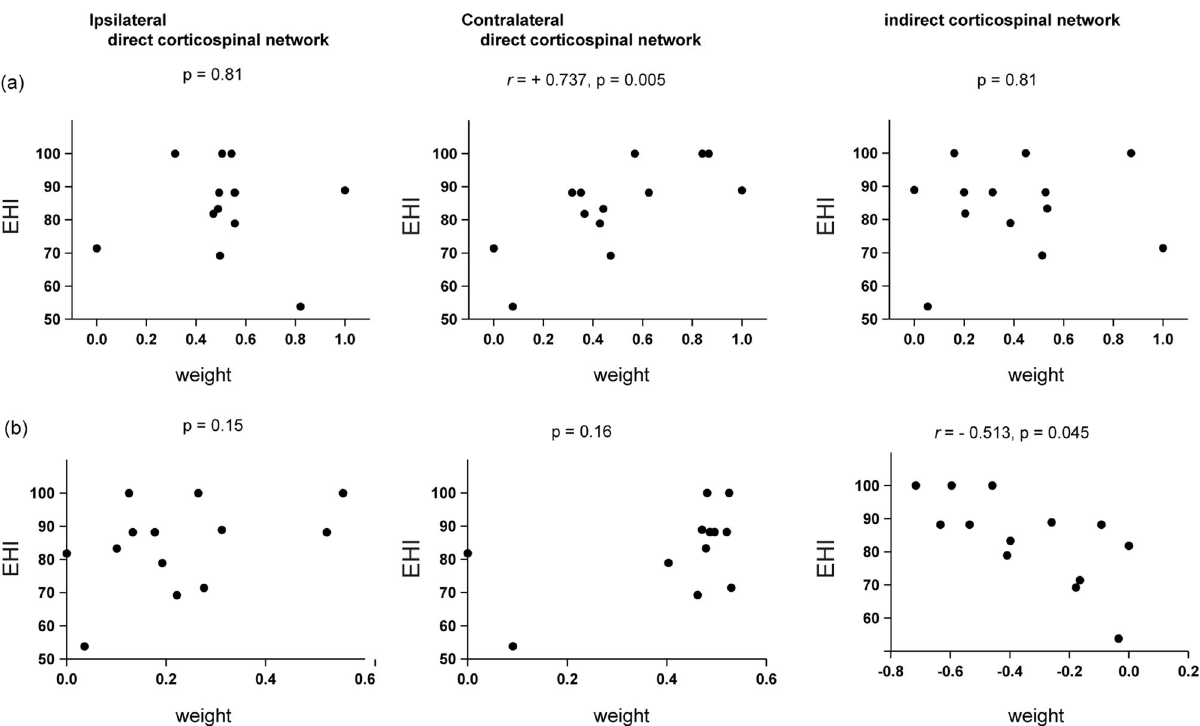
Fig. 4 Correlation between the involvement of the direct or indirect corticospinal networks in hand movement and individual variability in the degree of hand preference. For each individual, we computed the weights for each of the single terms and interaction terms. The scatter plots represented the relationship between the weight for each component ( x -axis) and the EHI score ( y -axis). a The model for RHM. b The model for